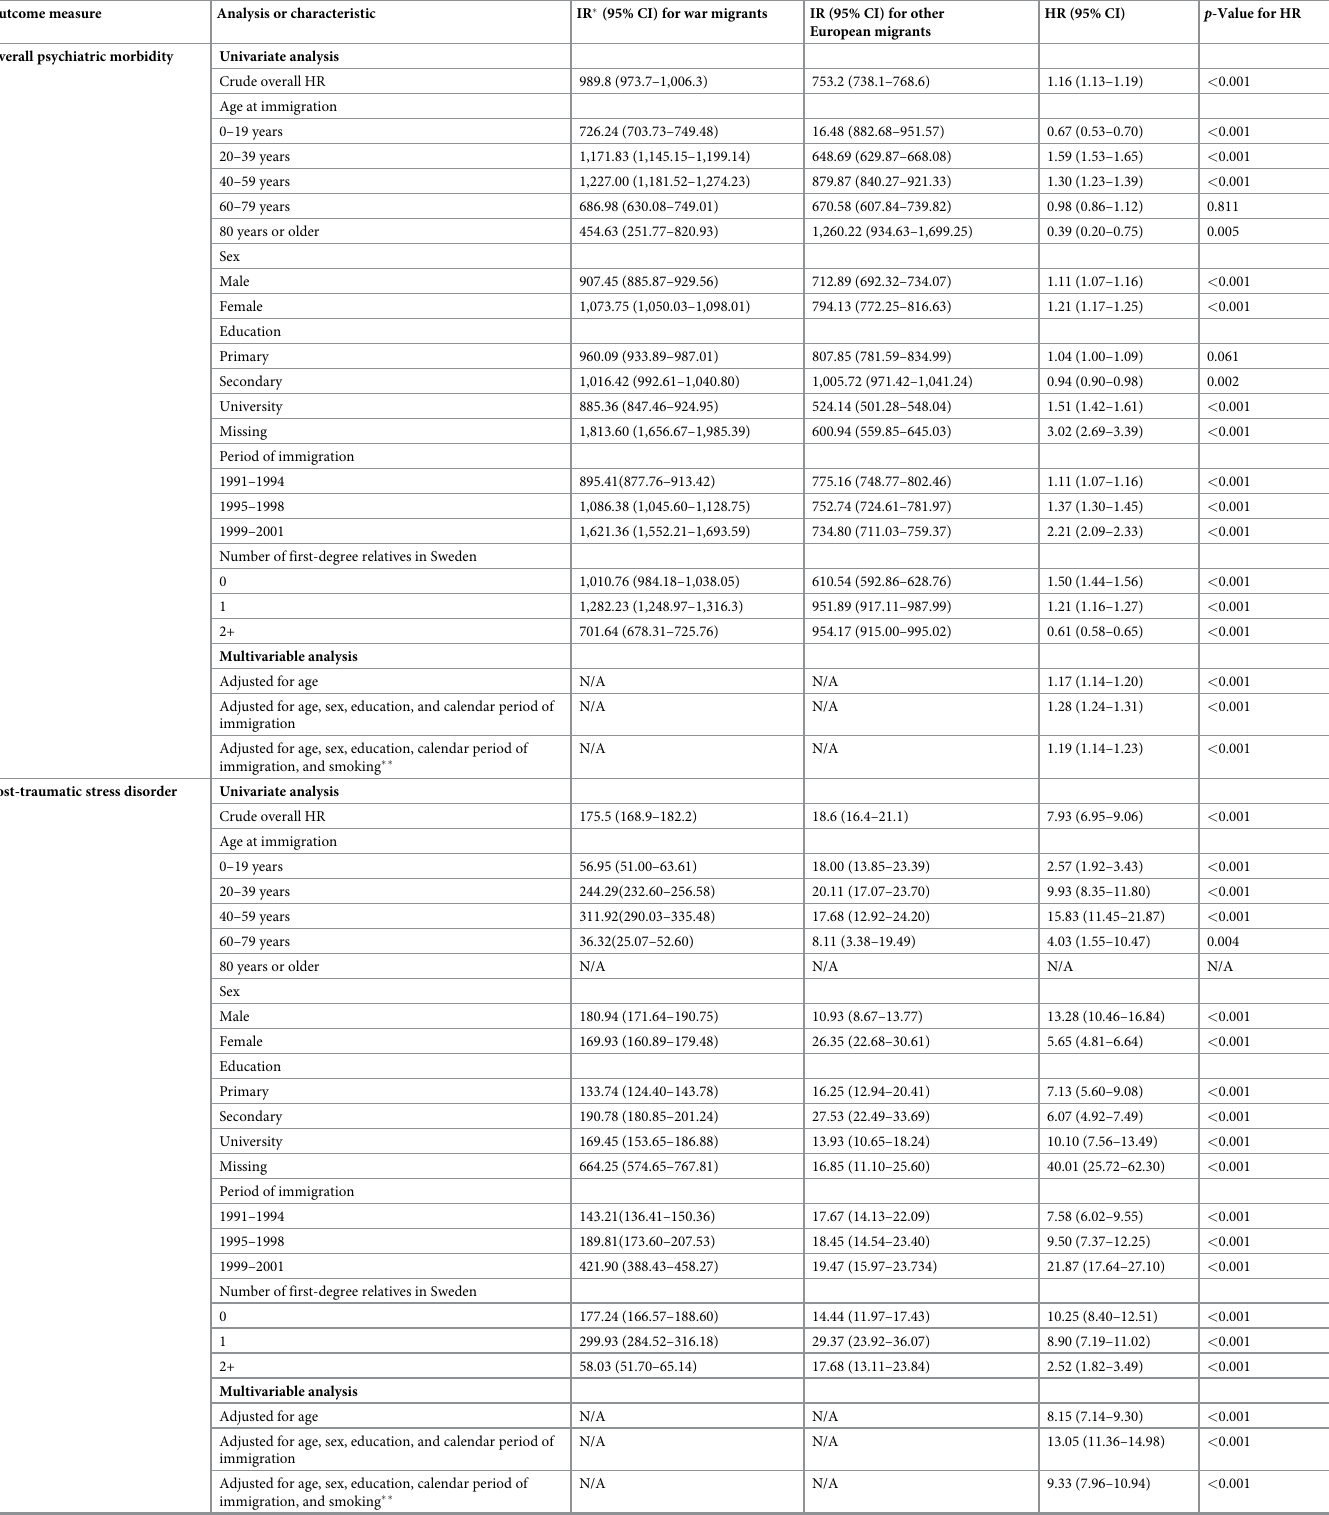
Table 4. Rates of morbidities in migrants of the Balkan wars compared to other European migrants, across strata of sociodemographic and lifestyle-related characteristics.